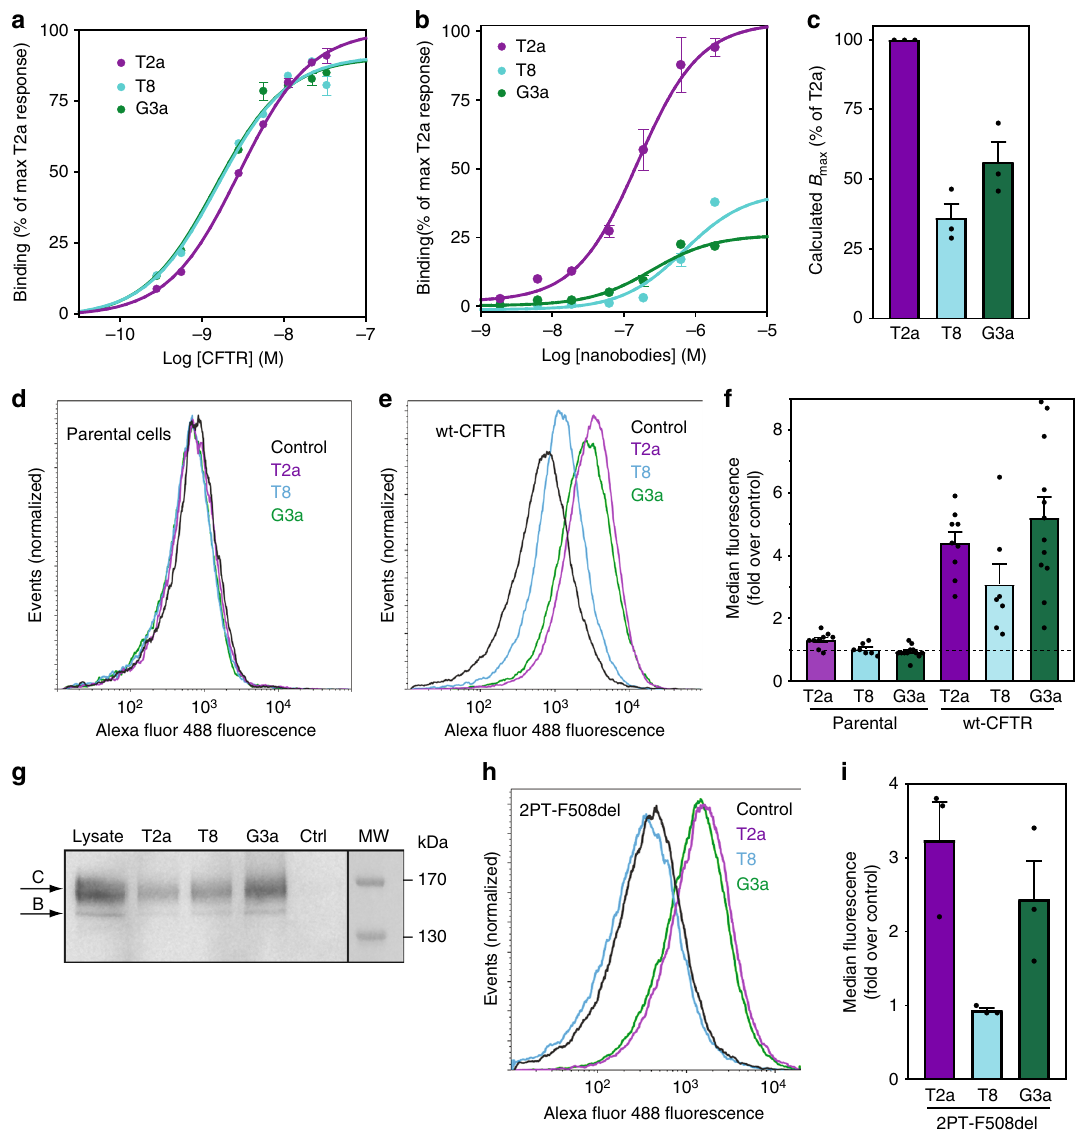
Fig. 4 Binding of nanobodies to FL-CFTR. a Dose – response ELISA of interactions between wt-CFTR and nanobodies. Immobilized nanobodies (T2a, T8 and G3a) were incubated with different concentrations of puri fi ed CFTR. b Immobilized puri fi ed wt-CFTR was incubated with increasing concentrations of nanobodies. For both ( a , b ) Data were normalized to maximal response of T2a after subtraction of the signal from the negative control nanobody. Graph depicts one representative of at least three independent experiments. Error bars represent standard deviations of triplicates. c Average B max of